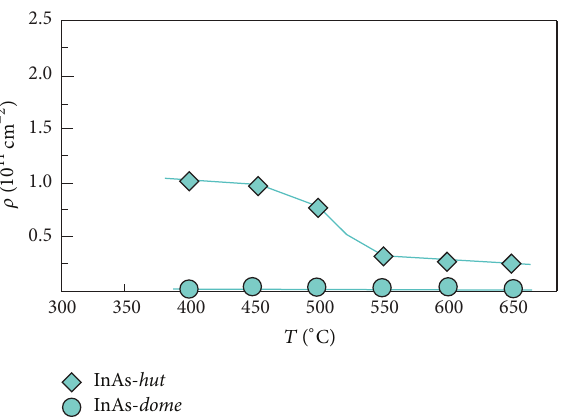
Figure 7: Temperature dependence of InAs nanoislands surface density.